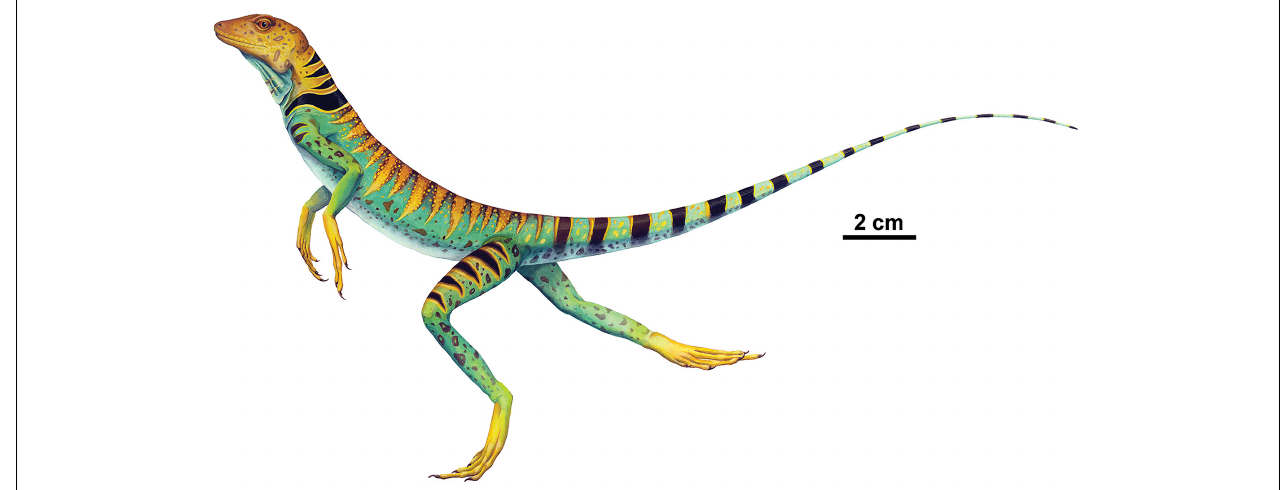
FIGURE 8 | Whole-body restoration of Eudibamus cursoris running bipedally based on the holotype (MNG 8852). Illustration by Sandra